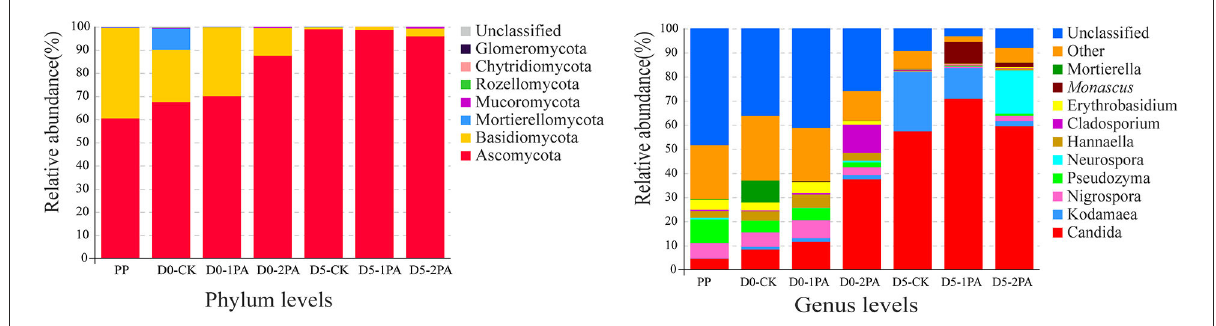
FIGURE5 Relative abundance of fungal communities for Napier grass silages treated without or with 1 and 2% pyroligneous acid after 30 days of ensiling and 5 days of exposure to air. PP, fresh material.